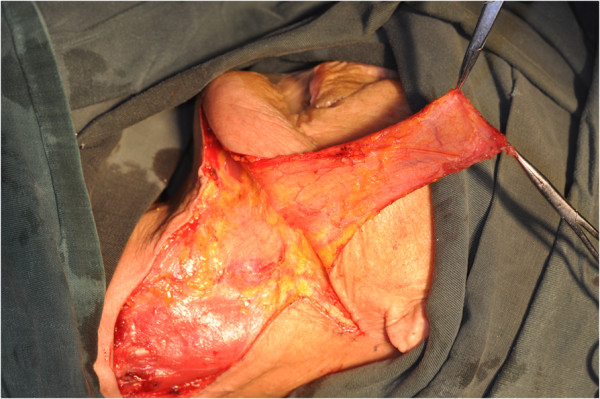
The flap was harvested using sharp dissection with a surgical knife under the adipofascial tissue below the platysmal plane.